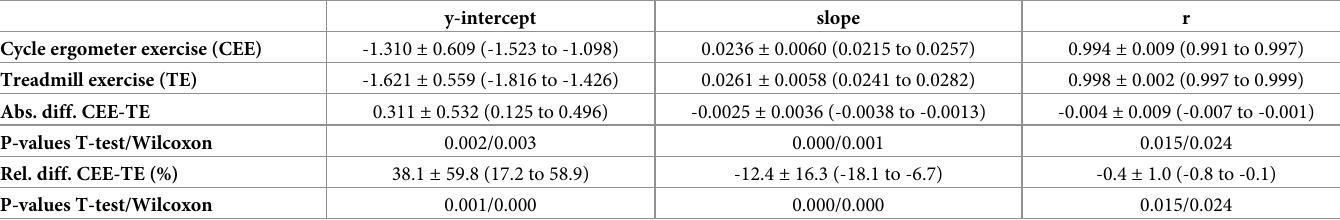
Table 5. Regression equations of model 2, and the absolute and relative exercise mode differences (n = 34, means ± SD, (95% CI) and P-values).